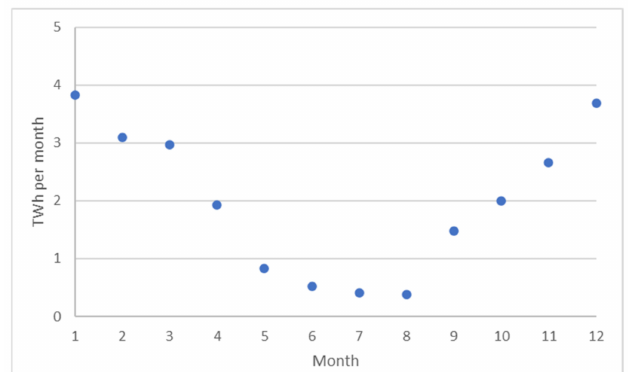
Figure 10. Monthly distribution of energy consumption replacing gas for heating and heating oil for EDS, BES, and